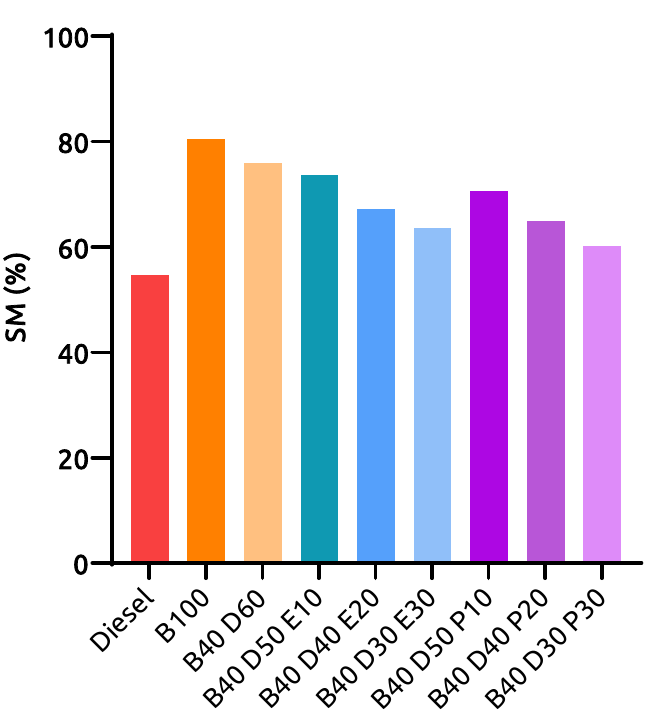
Figure 10. Smoke opacity for tested fuels at full engine load.